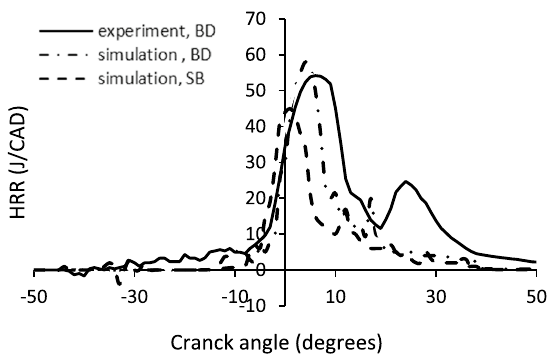
Fig. 8 Heat release rate (HRR) for base diesel (BD) and soybean biodiesel (SB) fuels at 100% of engine rated load